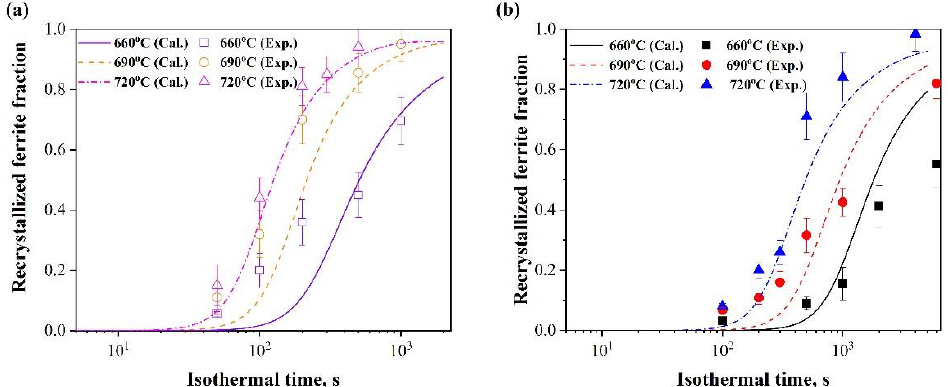
Figure 7. Comparison between calculated and measured recrystallized fraction of different steels at a series of different temperatures (660, 690, 720 °C): ( a ) Ti steel and ( b ) Ti-V steel.